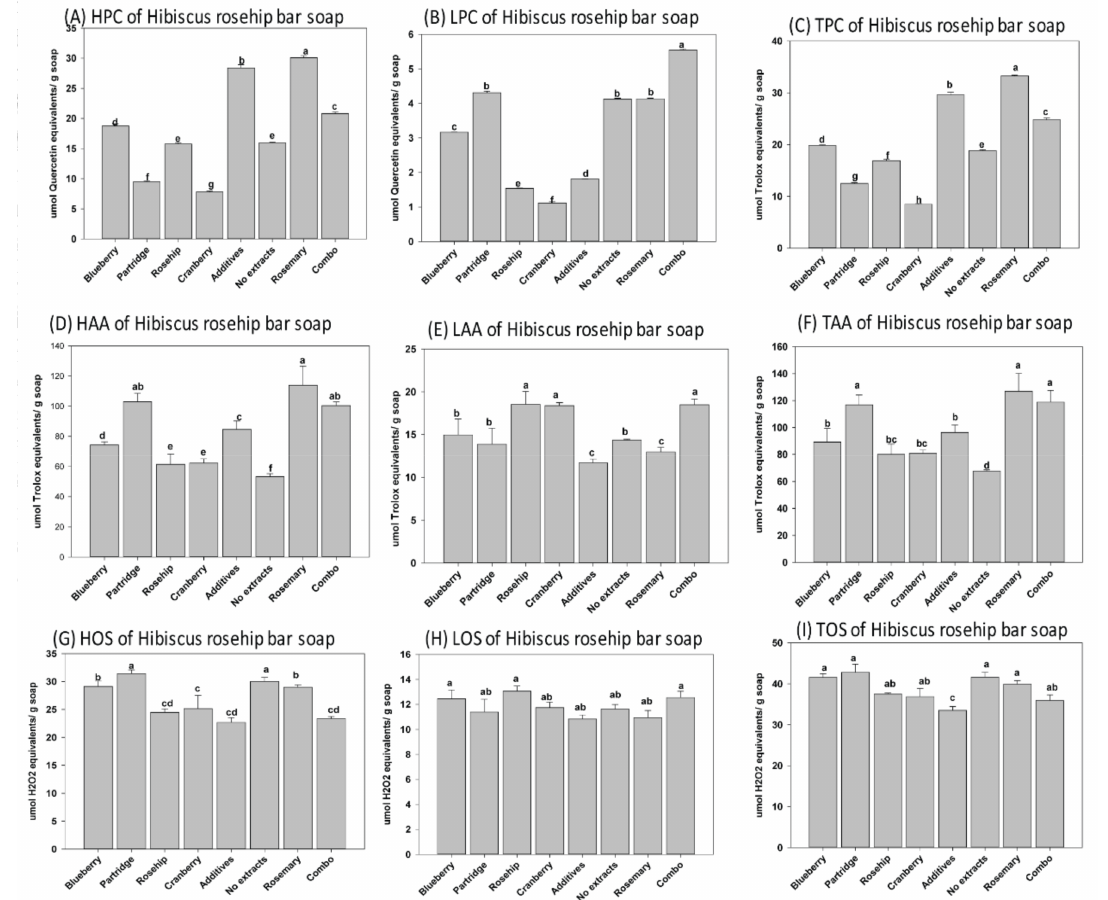
Figure 4. Hydrophilic, lipophilic, and total ( A – C ) phenolics, ( D – F ) antioxidants, and ( G – I ) oxidant status in the hibiscus rosehip (HR) natural soaps following manufacturing by cold saponification. Bars represent the mean ± standard errors. Error bars with di ff erent letters (a–g) are significantly di ff erent among treatments at LSD = 0.05, n = 4 per experimental replicate. HPC = hydrophilic phenolic content, LPC = lipophilic phenolic content, TPC = total phenolic content, HOS = hydrophilic oxidant status, LOS = lipophilic oxidant status, TOS = total oxidant status, HAA = hydrophilic antioxidant activity, LAA = lipophilic antioxidant activity, and TAA = total antioxidant activity. Combo = 25% of each of the blueberry, cranberry, and partridge berry and rosehip